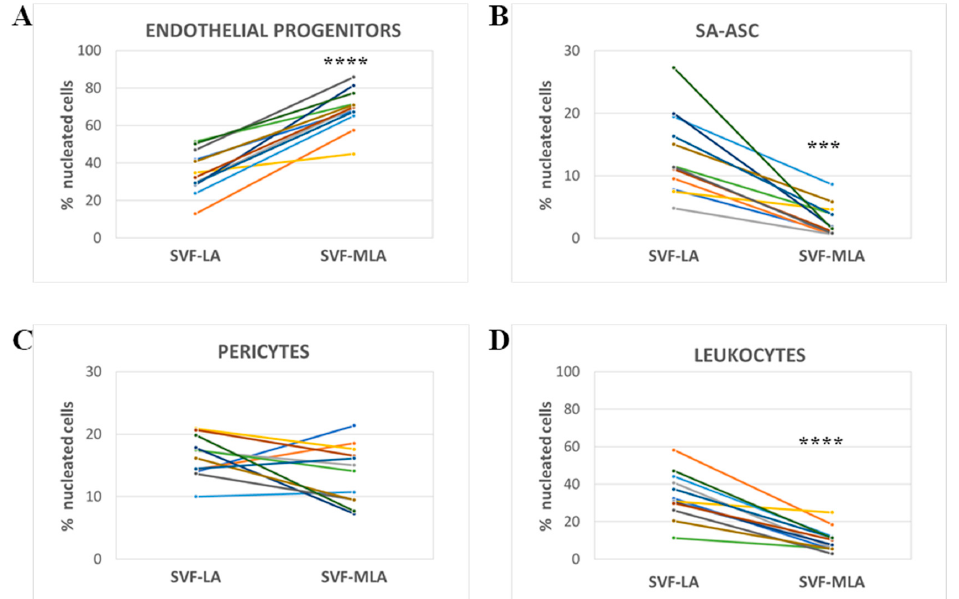
Figure 5 . Comparative analysis of four cell subpopulations in SVF obtained from SVF-LA or its SVF-MLA counterpart. The quantitative data of the polychromatic flow cytometry analysis show the difference in the percentage of the three progenitor cell types ( A,B,C ) and leukocytes ( D ) between the SVF-LA and SVF-MLA of each donor. p -values from p < 0.01; (***) p < 0.001; (****) p < 0.0001; n = 12.